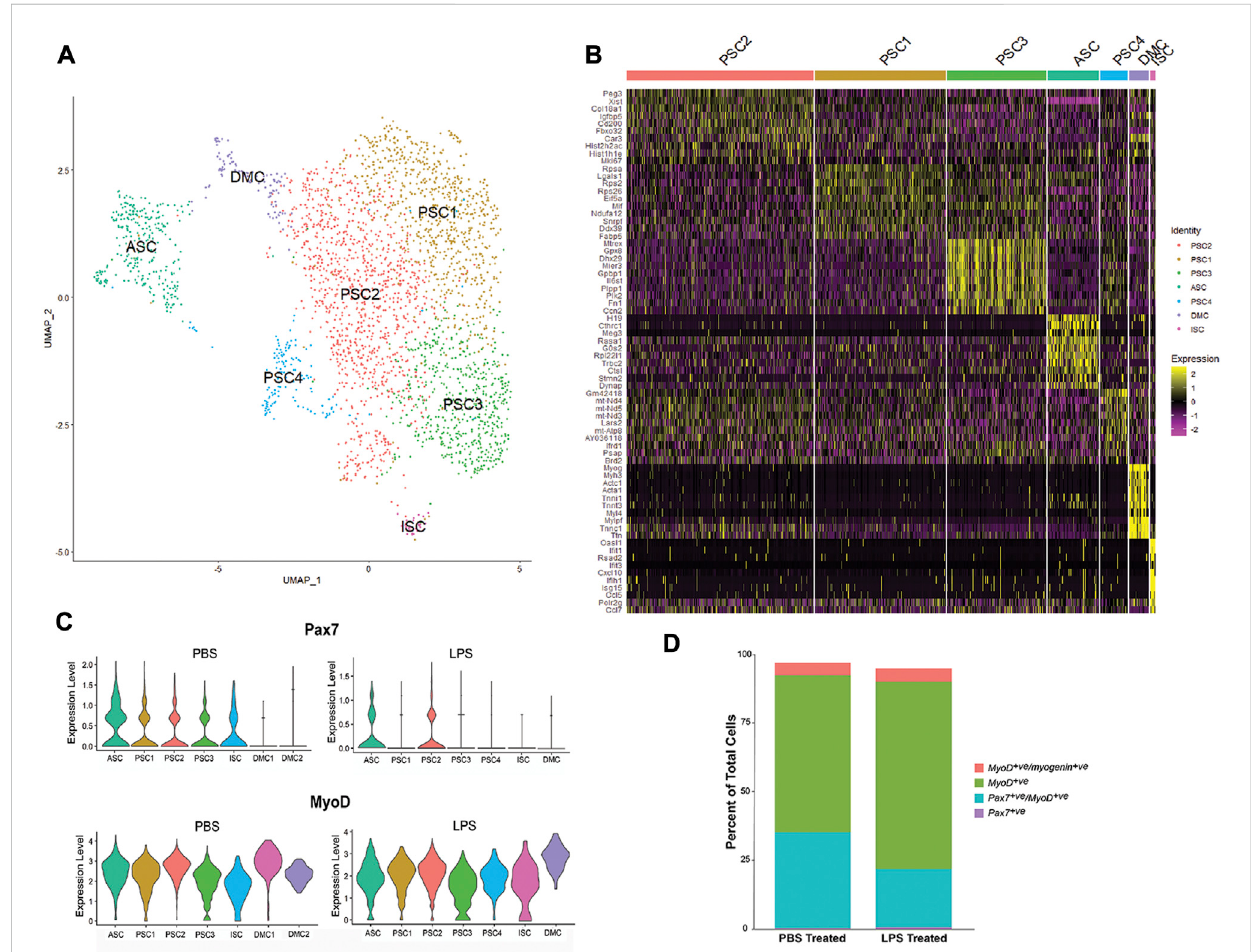
FIGURE 4 Single-cell RNA-SEQ analysis of LPS-treated primary mouse MuSCs. ( A) UMAP clustering of the LPS-treated MuSC. Cells cluster into seven groups based on differential gene transcription. (B) Heatmap depicting top 10 differentially expressed genes for each cluster. (C) Violin plots of Pax7 and Myod1 transcription in PBS and LPS treated MuSCs. (D) The distribution of satellite cells ( Pax7 +ve only), activated satellite cells ( Pax7 +ve /Myod1 +ve ), proliferating myoblasts ( Myod1 +ve only) and differentiating myocytes ( Myod1 +ve /Myog +ve ) in PBS and LPS treated cultures. Cell populations are presented as percent of the total